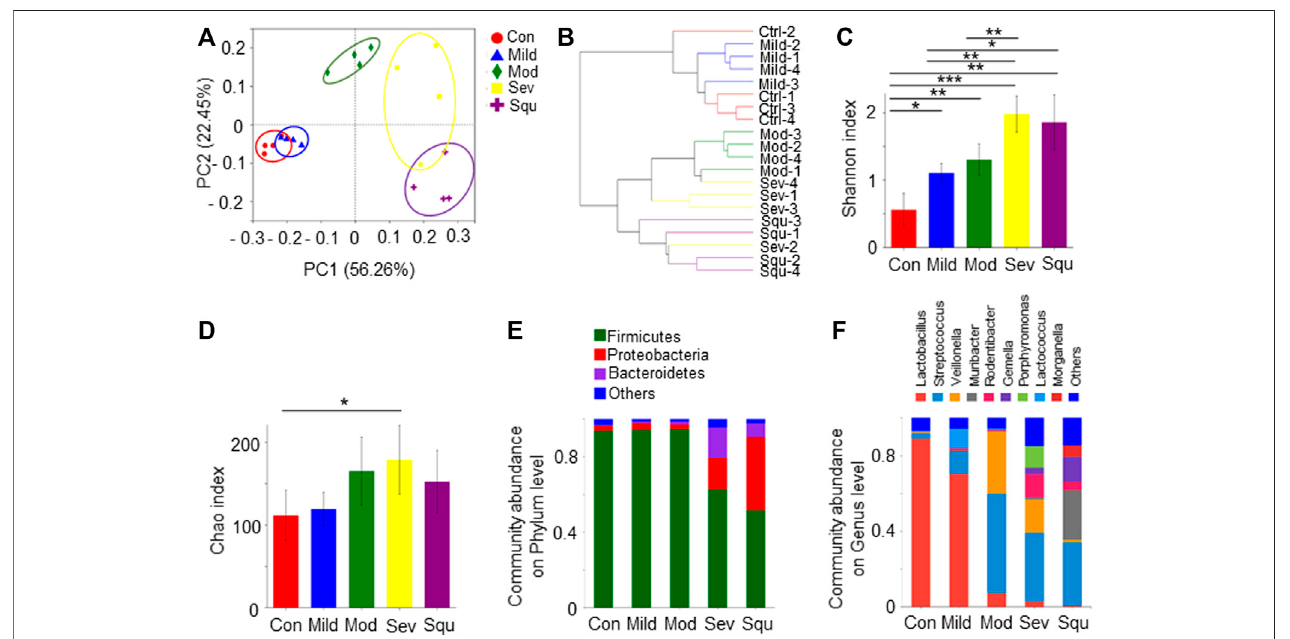
FIGURE 1 | Composition and diversity of oral fl ora in mice with dysplasias and OPC. SPF BALB/C mice were treated with or without 100 mg/L 4NQO in drinking water for 0 – 16 weeks. After the treatment, mice were sacri fi ced and the glossopharyngeal tissues were collected. Total DNAs were isolated from the glossopharyngeal tissues of mice as described in Materials and Methods and subjected to 16S rRNA sequencing. (A) PCA of oral fl ora. (B) Hierarchical clustering maps of oral fl ora. (C) Shannon index of oral fl ora. (D) Chao index of oral fl ora. (E) Composition of oral fl ora on phylum level. (F) Composition of oral fl ora on genus level. Data represent mean ± SEM. * p < 0.05, ** p < 0.01, *** p < 0.001, n = 4, compared with